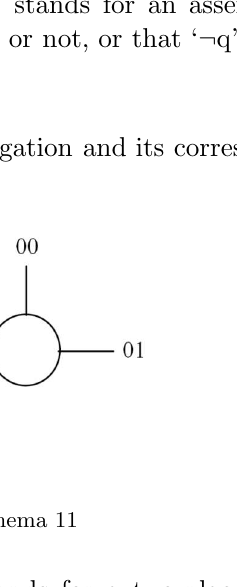
Schema 11 stands for a two-place basic formula: ⌊ p q ⌋ (pq), which means the whole expression is true iff ‘p’ is false (has value 0) and ‘q’ is true (has value 1), or both ‘p’ and ‘q’ are false. Graph 28 (also see graph 8 (c), 8(d)) stands for an assertion: ⊢ ¬ p. It means that ‘p’ is false whether ‘q’ is true (has value 1) or not, or that ‘ ¬ p’ is true whether ‘q’ is true or